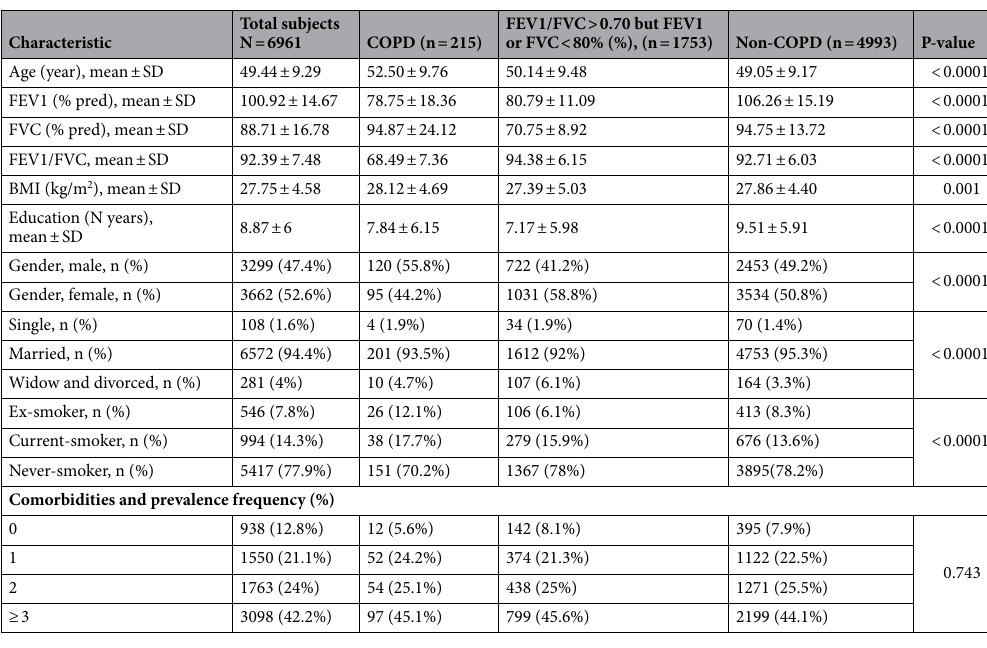
Table 1. Baseline characteristics of the Shahrekord cohort study; sub-cohort of COPD. COPD: chronic obstructive pulmonary disease; n: frequency; FEV1: forced expiratory volume in 1 s; FVC: forced vital capacity; BMI: body mass index.